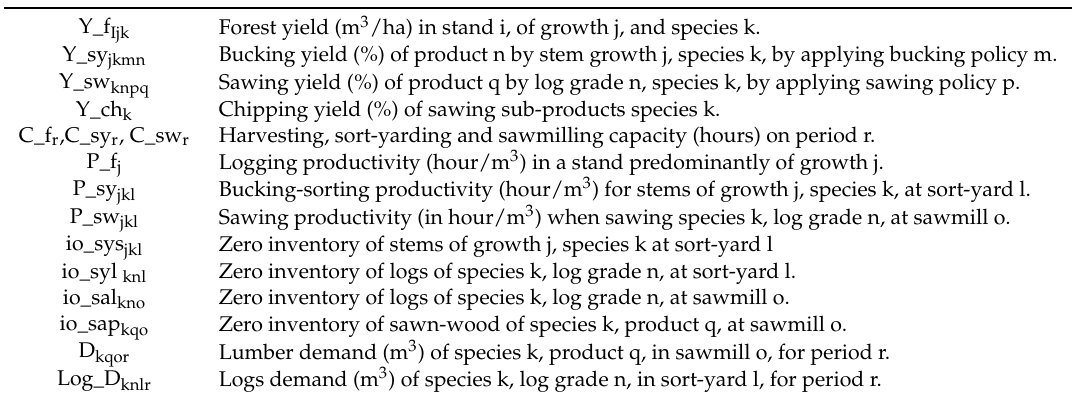
Table A3. Yields, capacities and productivities.